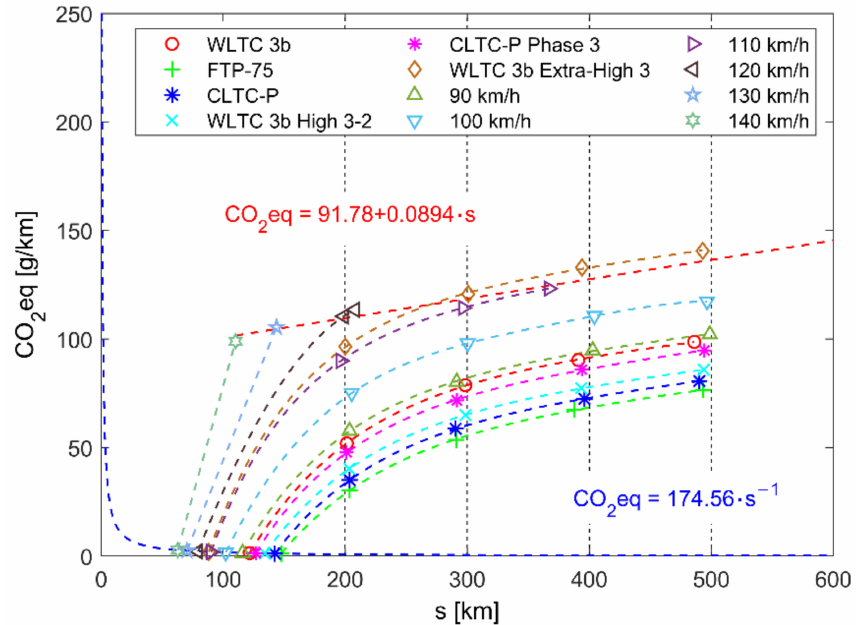
Figure 15. Combined CO 2 eq emission, due to EREV operation and electricity production (Sweden), in various driving conditions. Note that the blue approximation line (BEV mode) and the red approximation line (maximal range) are obtained for constant speed driving results from the range of 90–140